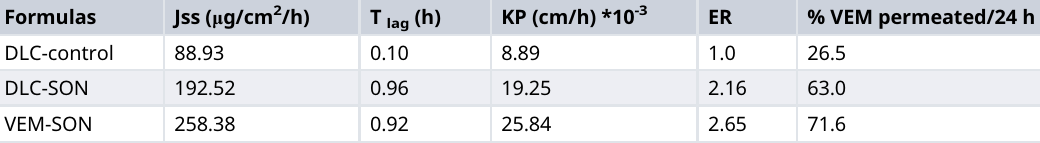
Table 4. Ex vivo permeability parameters of VEM from DLC-SON, the optimum VEM-SON and DLC-control.